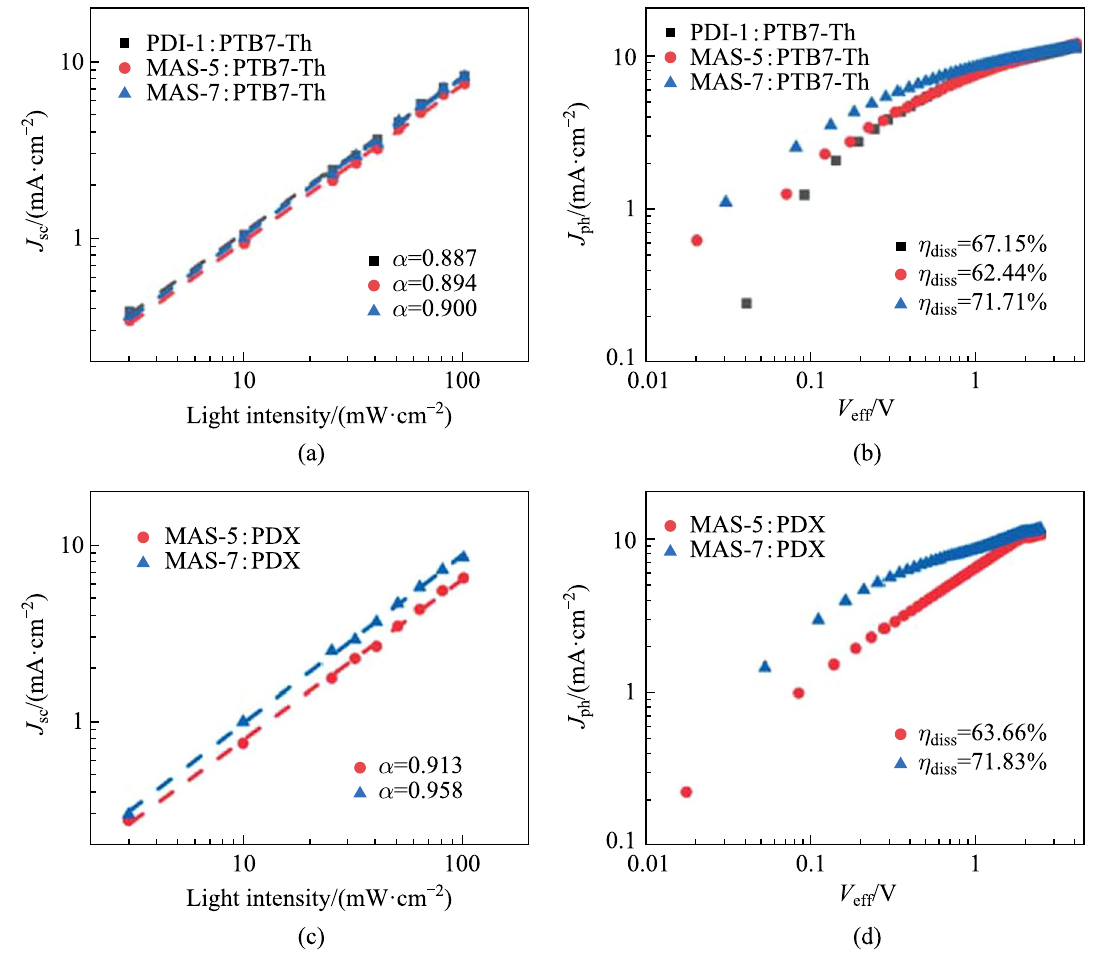
Fig. 5 Dependence of J sc on incident light intensity for the a PTB7-Th-based OSCs and c PDX-based OSCs and the saturated photocurrent ver- sus effective voltage ( J ph − V eff ) curves of the b PTB7-Th-based OSCs and d PDX-based